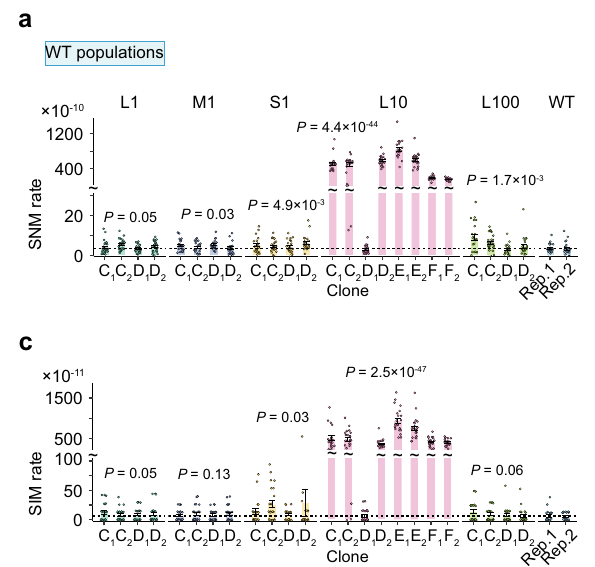
Fig. 2 | Evolution of mutation rates. Evolved single-nucleotide mutation (SNM) ratesfor( a )WTclonesand( b )MMR-clones. n =25,22,25,24,24,24,23,and25(L1- A1, A2, B1, B2, C1, C2, D1, and D2, respectively); n =23, 25, 22, 23, 25, 25, 24, and 24 (M1-A1, A2, B1,B2,C1,C2,D1, and D2, respectively); n =21, 25,22,25,22, 24,25,and 23(S1-A1,A2,B1,B2,C1,C2,D1,andD2,respectively); n =18,24,24,24,19,23,24,23, 23,24,22,and24(L10-A1,A2,B1,B2,C1,C2, D1,D2, E1, E2,F1,andF2, respectively); n =24, 24, 24, 25, 22, 25, 23, and 23 (L100-A1, A2, B1, B2, C1, C2, D1, and D2, respectively); n =21 and 24 (WT); n =25 and 24 (MMR-). Evolved small indel mutation (SIM) rates for ( c ) WT clones and ( d ) MMR- clones. n =25, 22, 25, 23, 24, 24, 24, and 25 (L1-A1, A2, B1, B2, C1, C2, D1, and D2, respectively); n =23, 25, 22, 23, 24,25,24,and24(M1-A1,A2,B1,B2,C1,C2,D1,andD2,respectively); n =20,25,23,